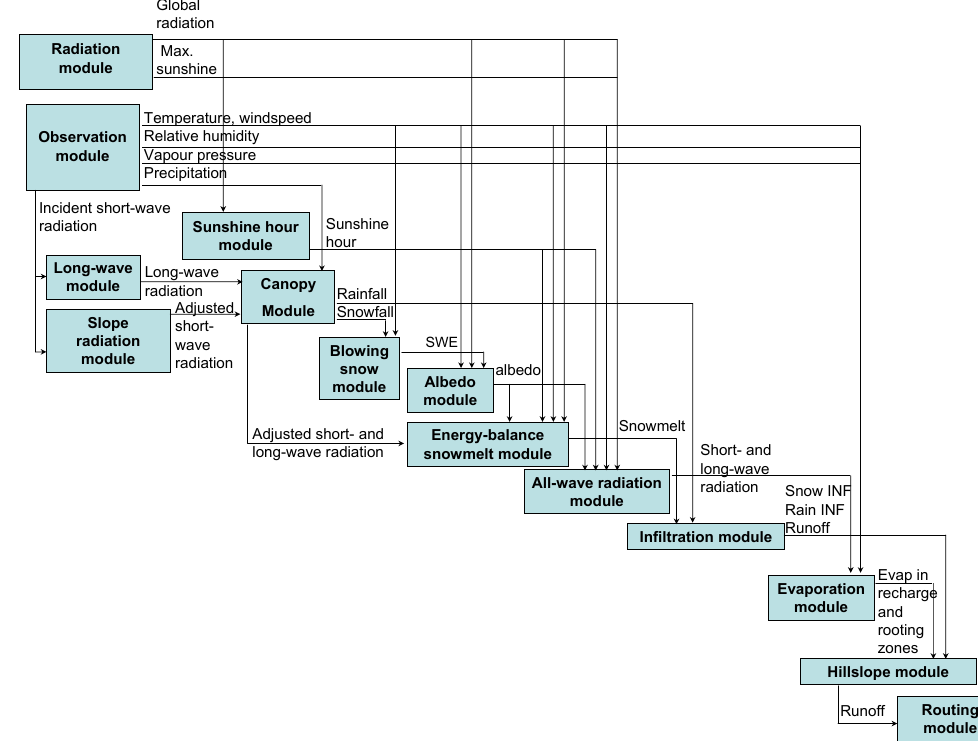
Fig. 2. Flowchart depicting the configuration of physically based hydrological modules in CRHM for simulating hydrological processes. This setup is repeated for each HRU to develop a mountain hydrology model in the Marmot Creek Research